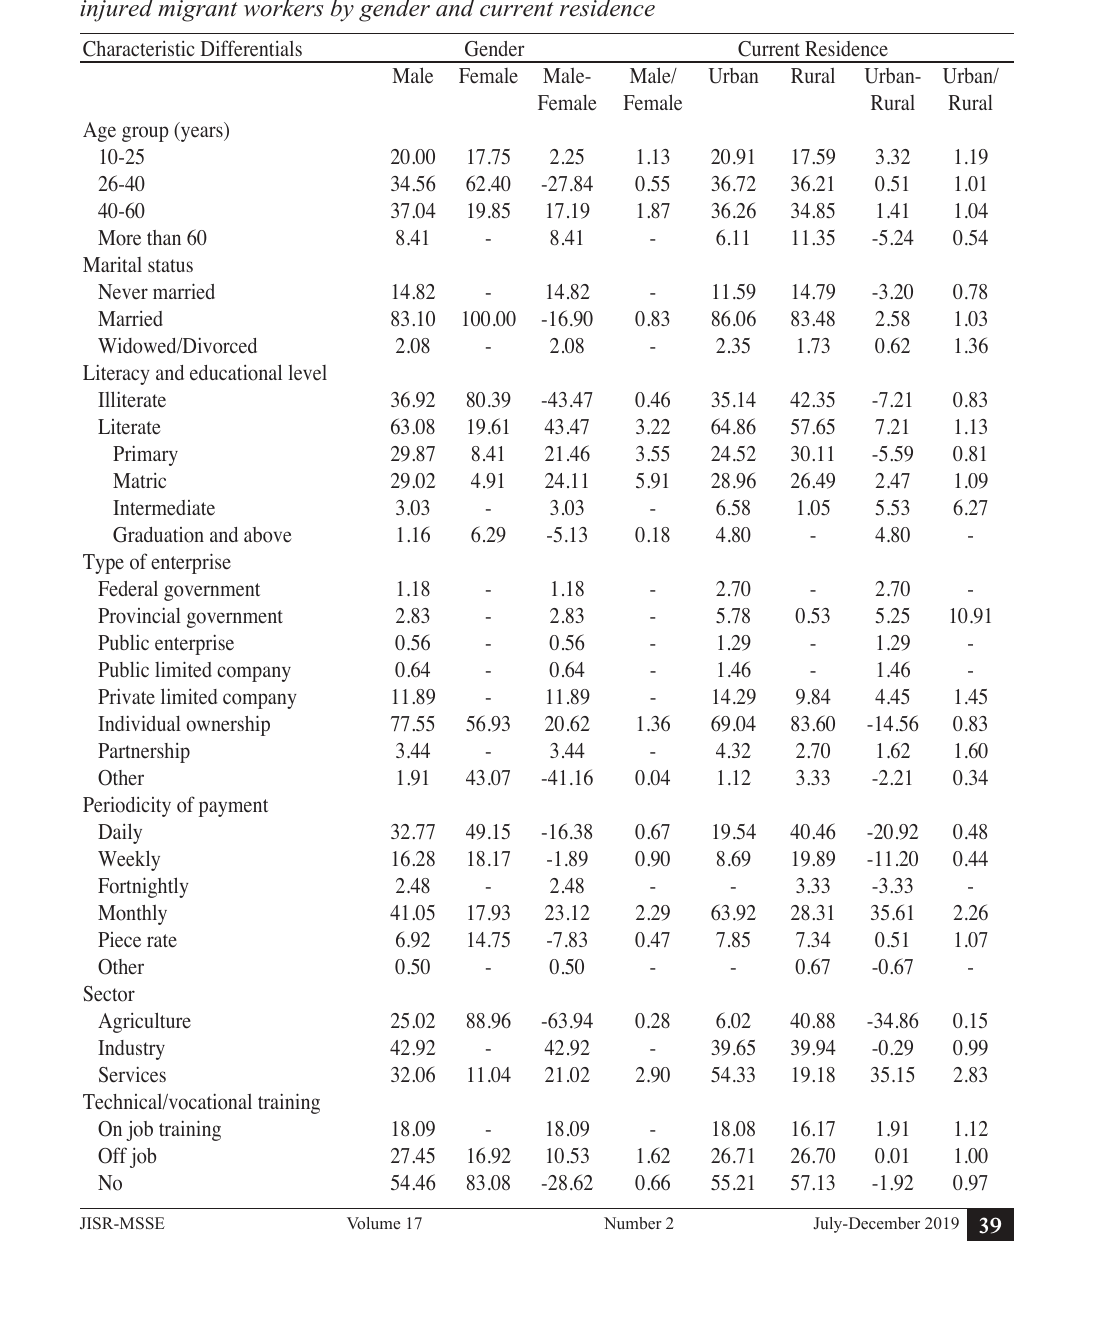
Proportions of the socio-demographic and economic characteristics of occupationally injured migrant workers by gender and current residence Characteristic